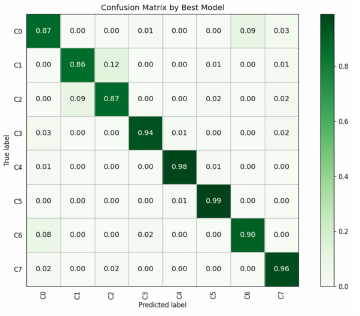
Figure 10. Confusion matrix by our proposed